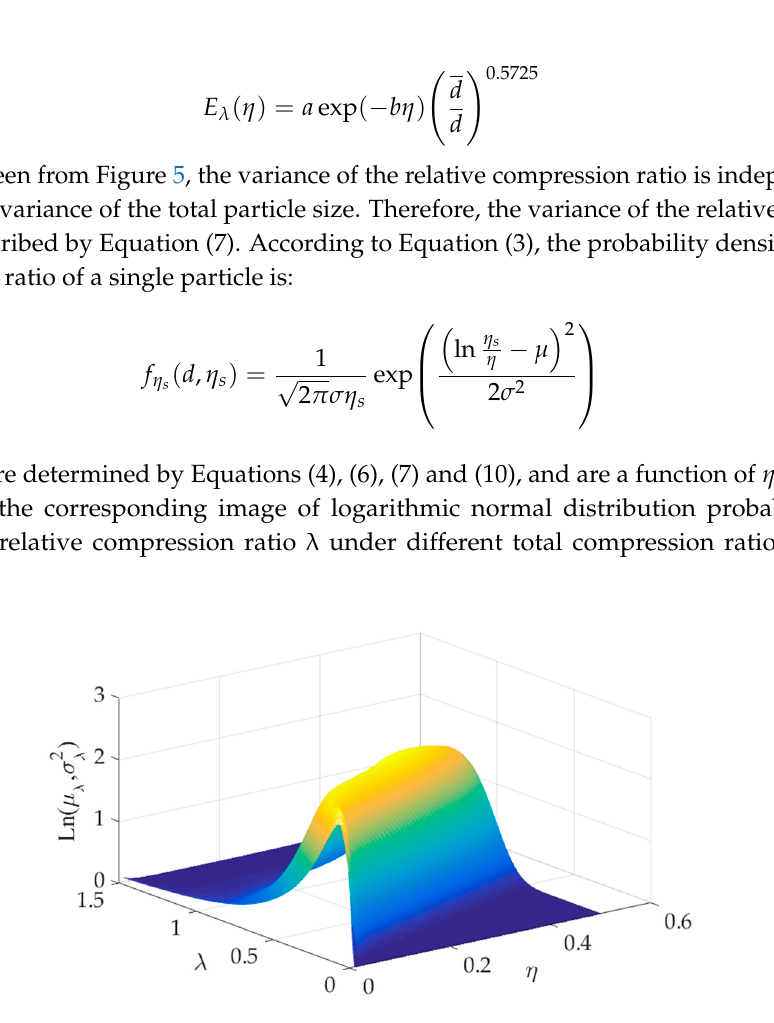
Figure 7. Total compression ratio and relative compression ratio and probability density function.